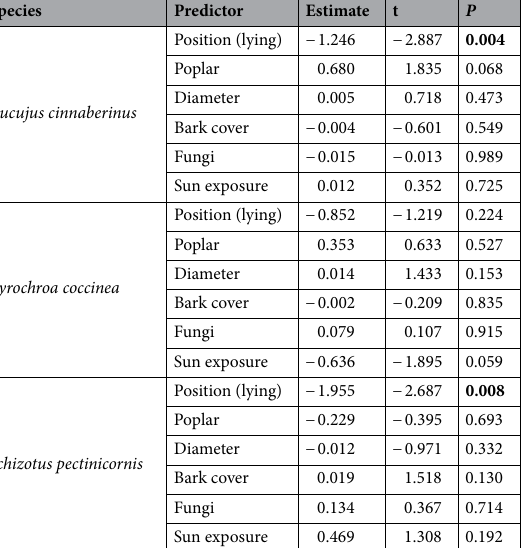
Species Predictor Estimate t P Position (lying) − 1.246 − 2.887 0.004 0.680 Cucujus cinnaberinus